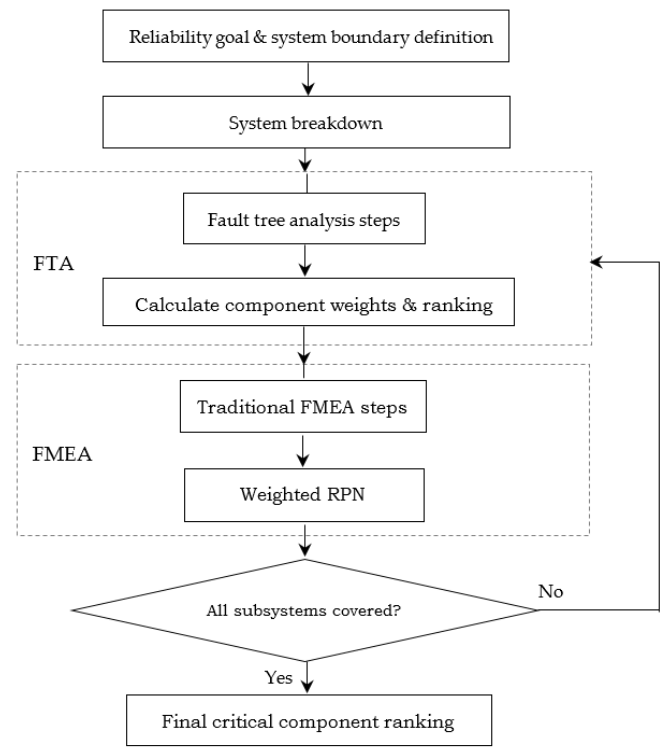
Figure 1. FTA-FMEA integration framework.